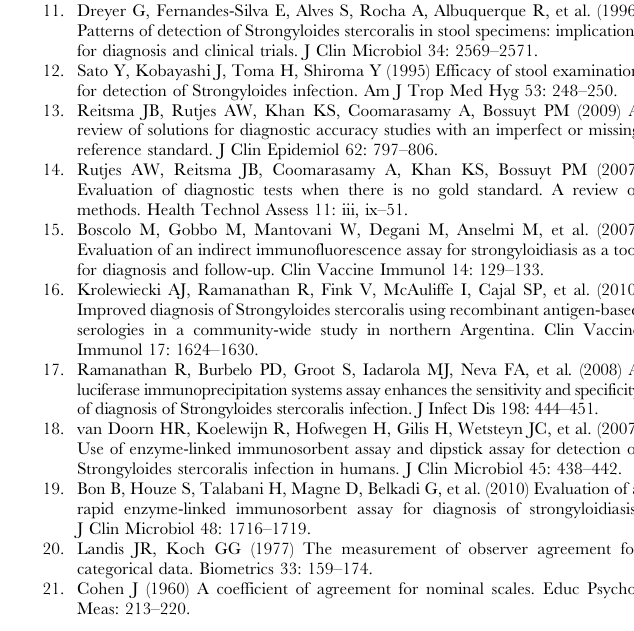
Table S3 Positive and negative predictive values (PPV, NPV) for different theoretical prevalence levels. Table S4 Positive and negative predictive values (PPV, NPV) for different theoretical prevalence levels. Table S5 Concordance between pairs of index tests (Kappa